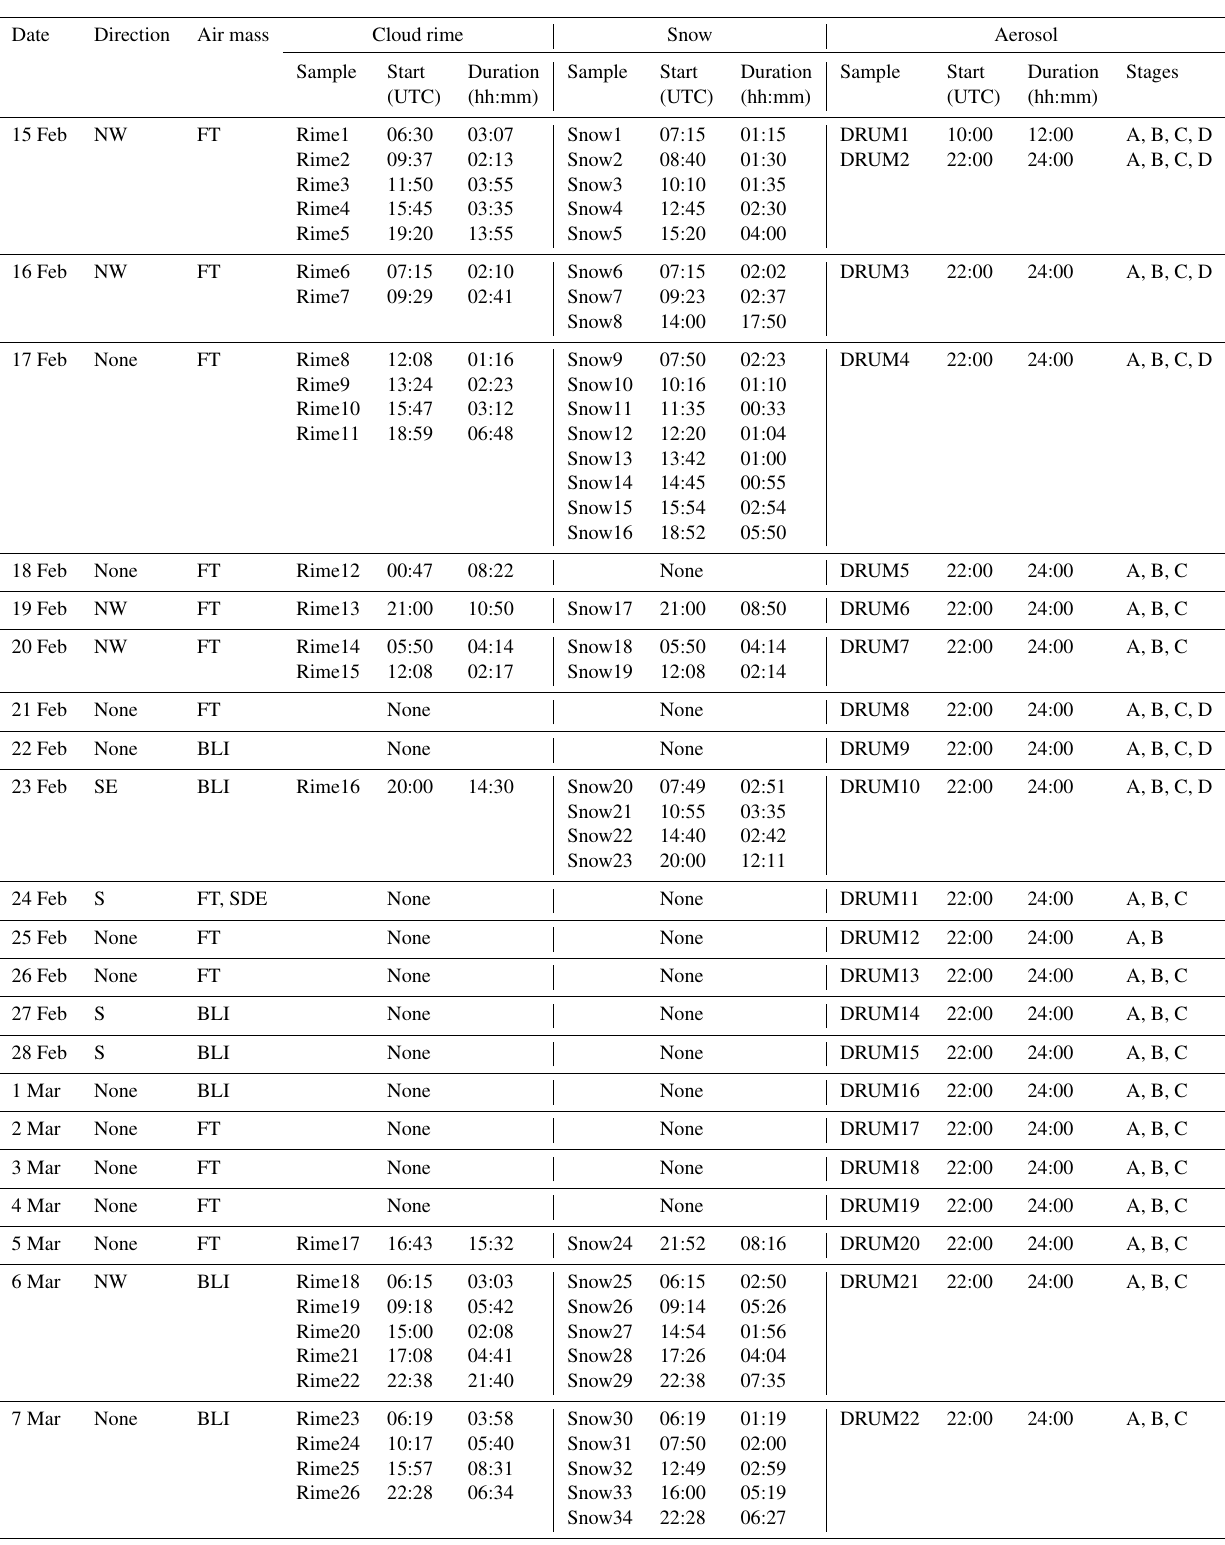
Table 1. Dates and times for cloud rime, snow, and aerosol samples collected during the 2018 winter INCAS study at Jungfraujoch. Also shown are the dominant air mass sources (free troposphere or FT or boundary layer intrusion of BLI) for each day based on radon data. Samples labeled as NW and SE under “Direction” are the northwest and southeast case studies, respectively. Samples labeled as S under “Direction” represent predominantly southerly days that were classified as Saharan dust events (SDEs) or BLI